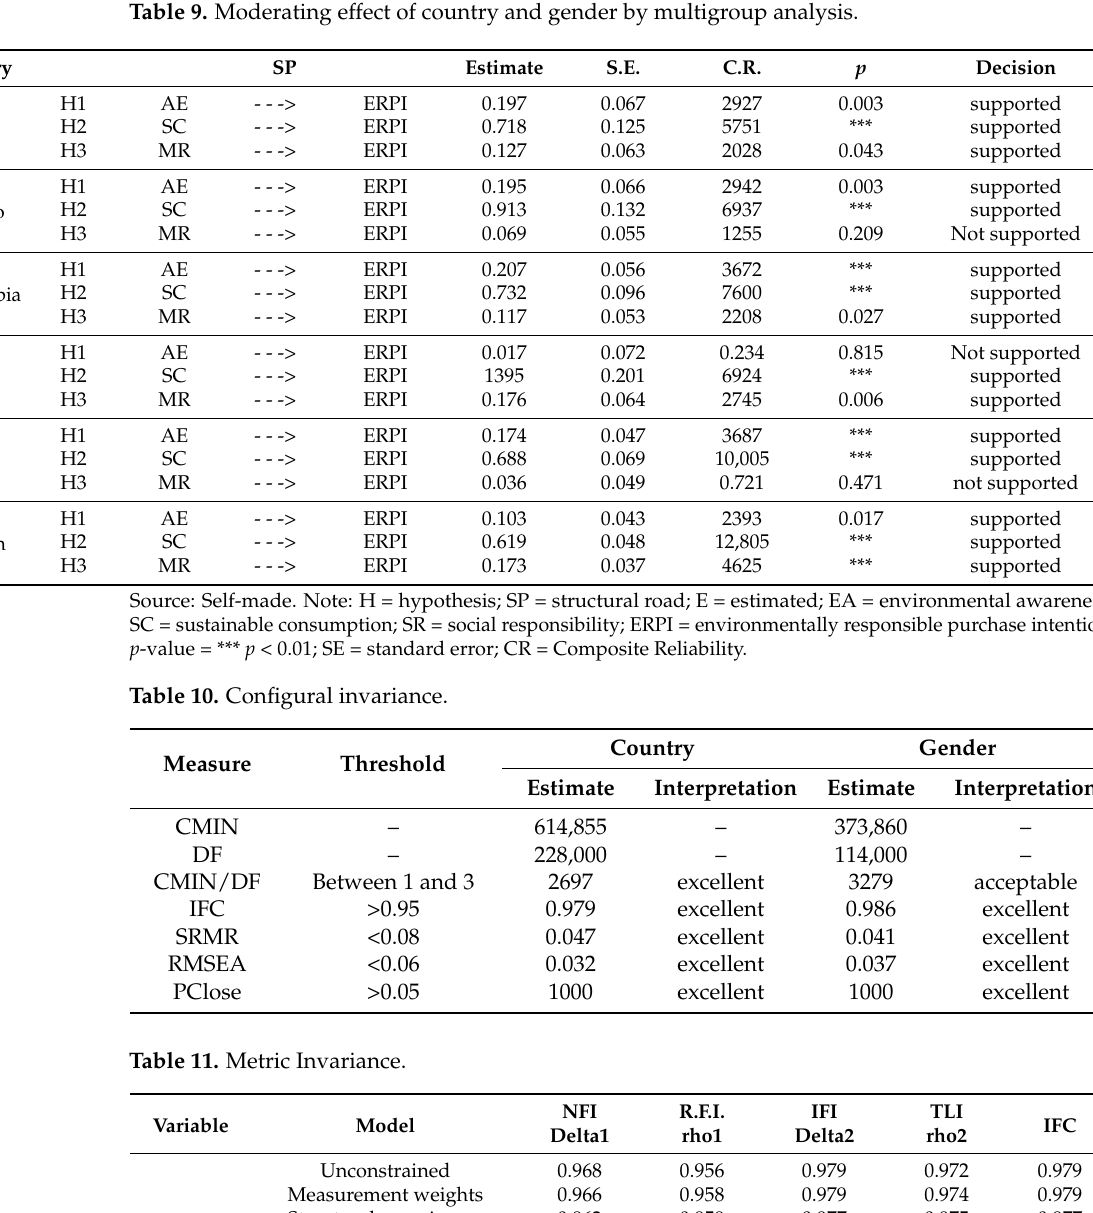
Table 9. Moderating effect of country and gender by multigroup analysis.